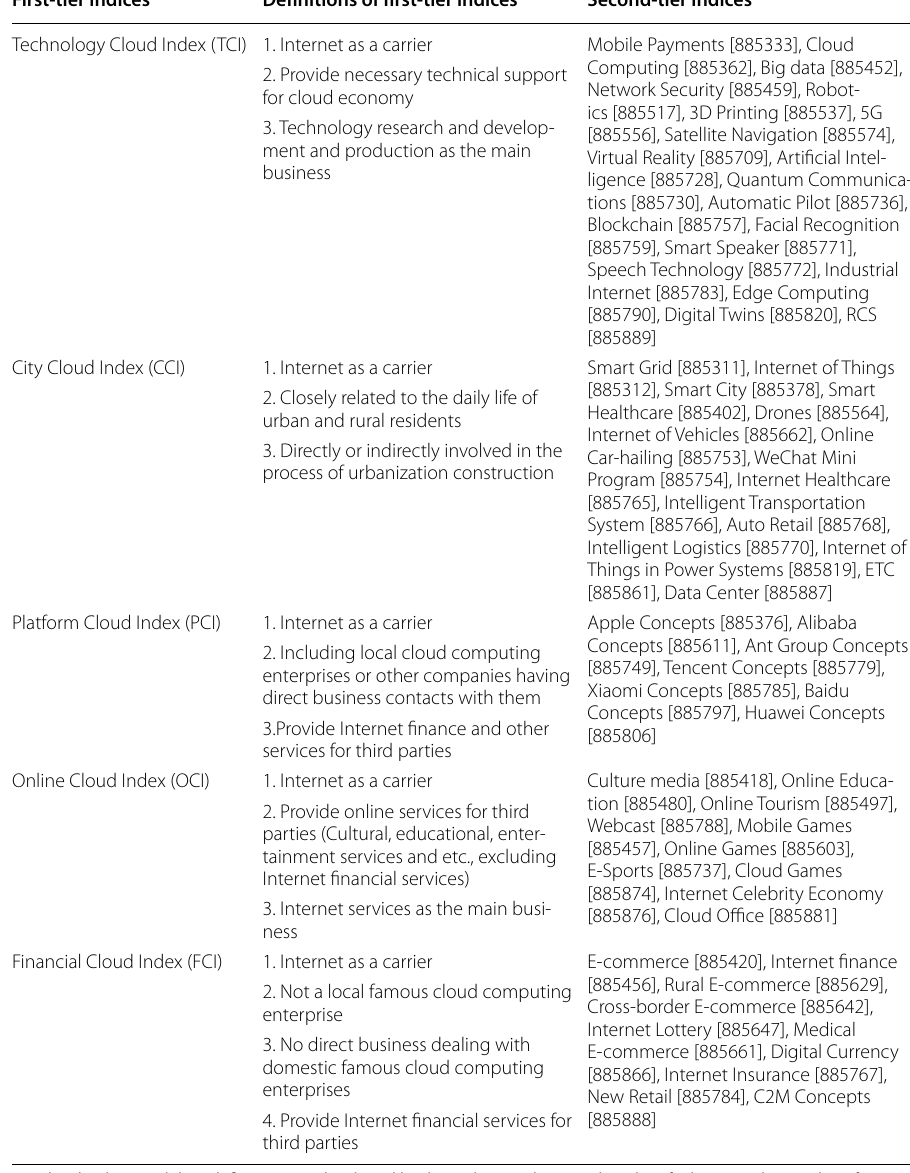
Table 1 The evaluation system of